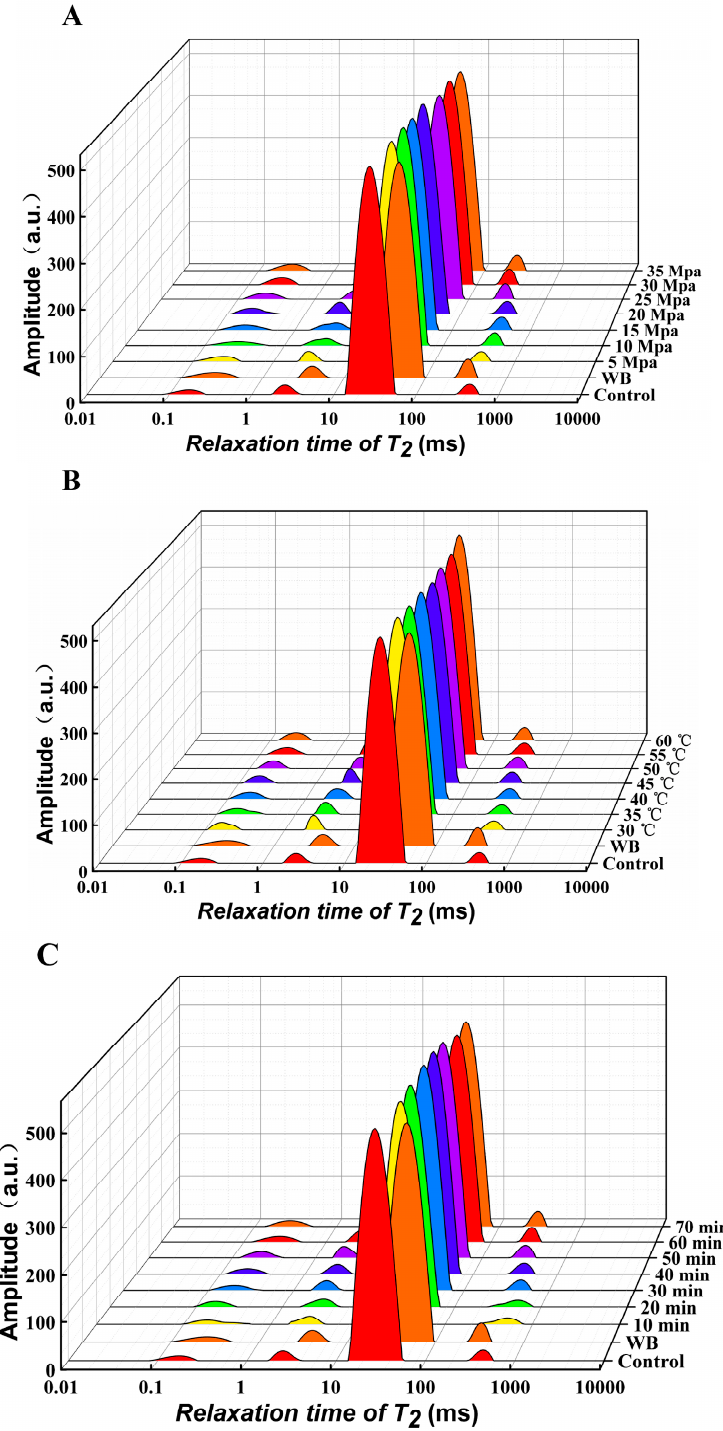
Figure 4. Effect of different DPCD treatments on the T 2 relaxation time of surimi ( A ): Pressure, ( B ): Temperature, ( C ): Time.